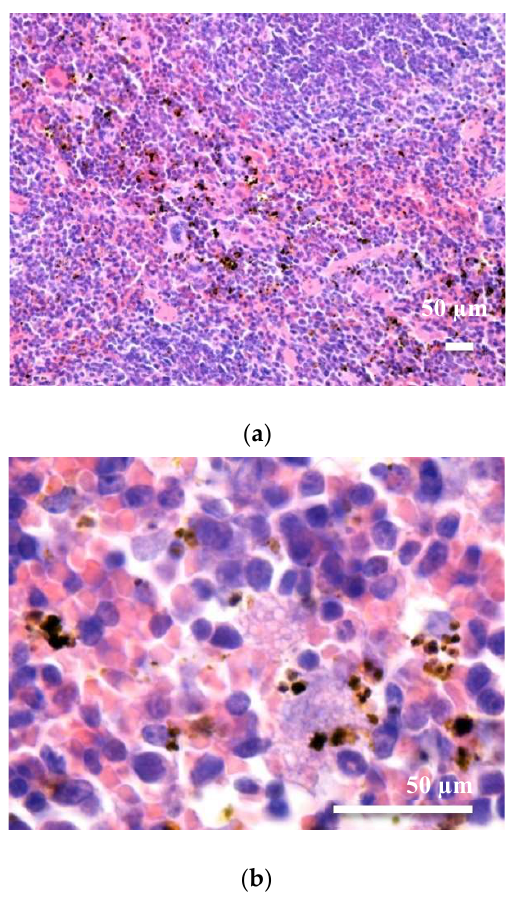
Figure 3. Optical micrographs of splenic tissue harvested at 10 days after injection of Fe 3 O 4 @CEF nanoparticles at 200× ( a ) and 1000× ( b ) magnification.